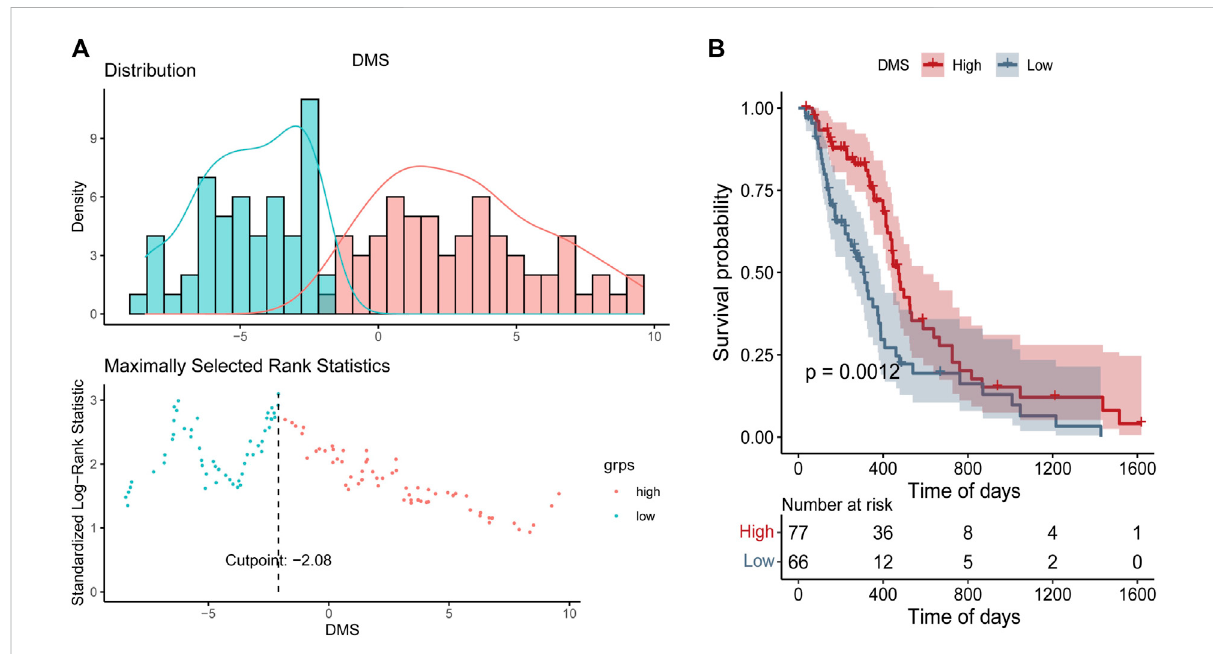
FIGURE 8 DNA Methylation Score (DMS) gradient grouping for tumors. (A) DMS distribution density statistics and optimal threshold determination. (B) Survival curves between groups with high and low